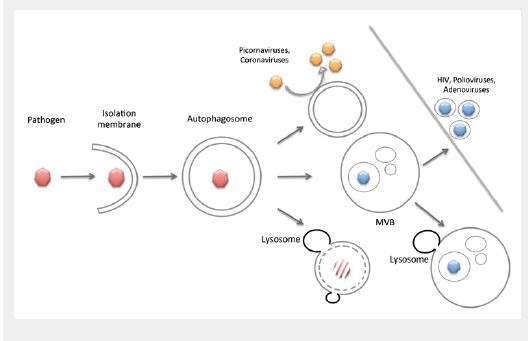
Macroautophagy in pathogen restriction and replication. Pathogens, like viruses, bacteria and parasites, can be degraded by macroautophagy, or might use autophagosomal delivery to multi- vesicular bodies for their release from the host cell. In addition, viruses re-model cytoplasmic membranes via macroautophagy in order to replicate on their